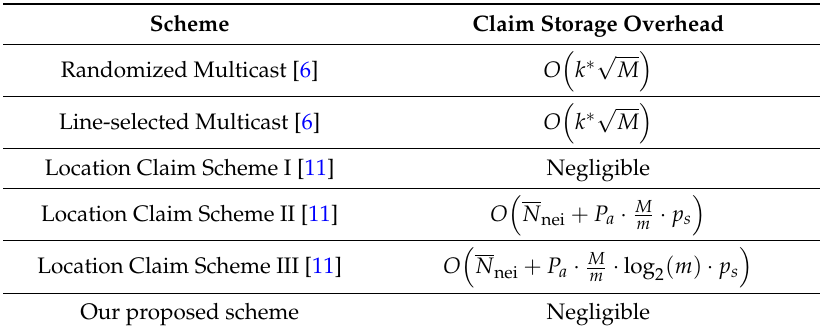
Table 4. Storage overhead